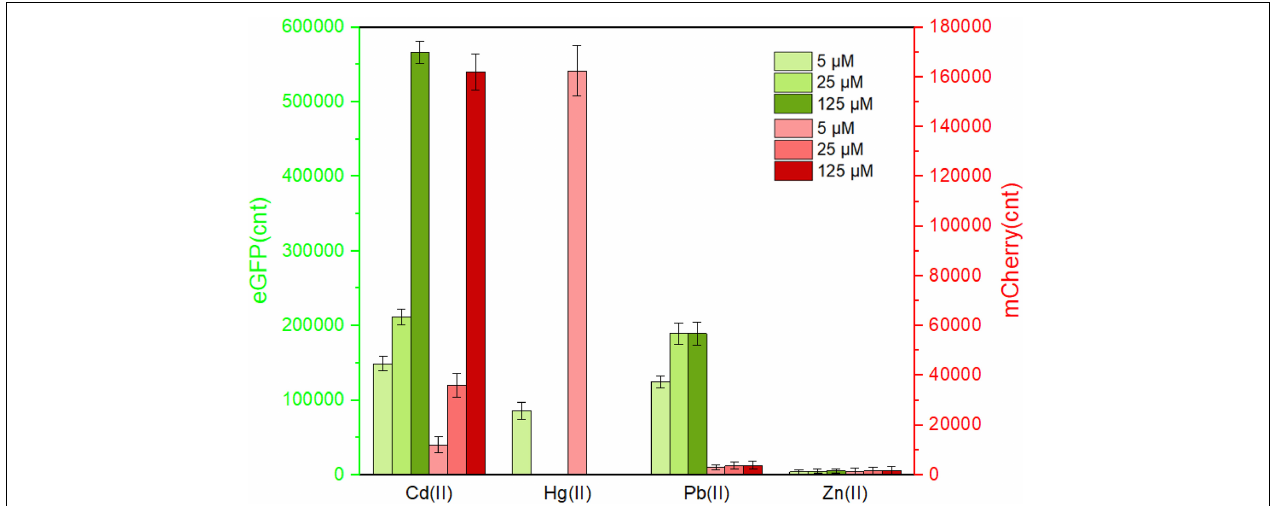
FIGURE 5 | The response of the dual-sensing biosensor toward different metal ions. Double-color fluorescence of whole-cell biosensor TOP10/pCadC-G-CadR-R in the presence of different metal ions was determined after a 12-h incubation at 37 ◦ C. Fluorescent values were divided by the optical density at 600 nm. The data values shown for each metal exposure group were obtained by subtracting the control values (with no metal exposure) from the experimental values. Results are the average of at least three independent experiments performed in triplicate.